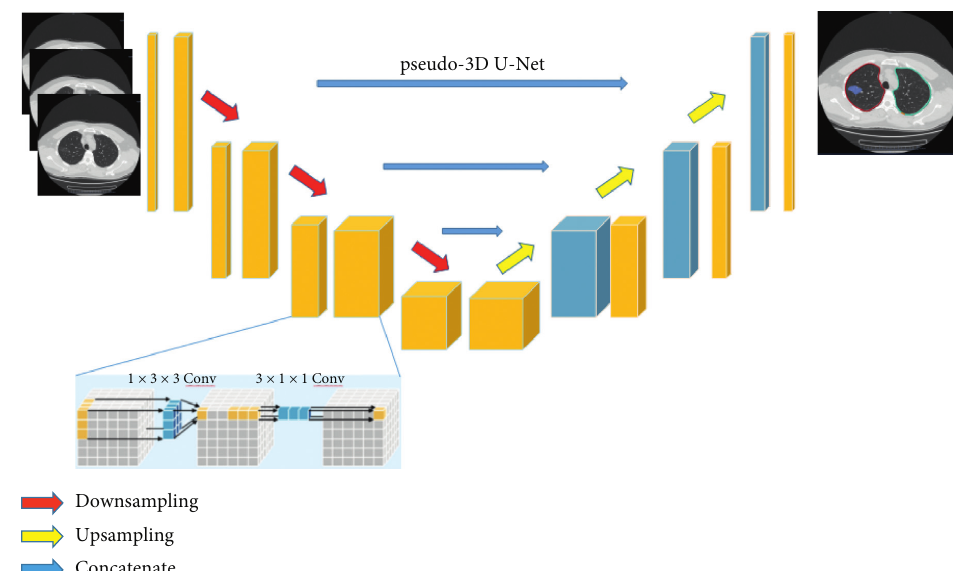
Figure 2: Lung infection and labeling and volume calculation were used to determine the volume of pulmonary inflammation.